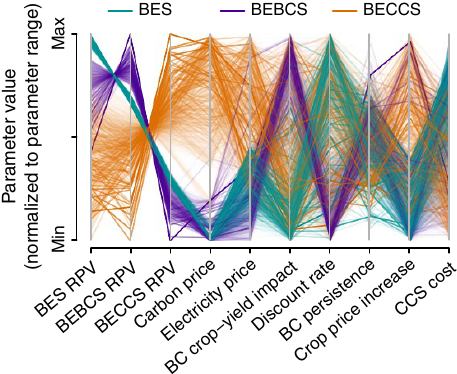
Figure 3 | Parallel coordinates plot of the relative net present values as a function of the most important parameters. Relative net present values (RPVs) of bioenergy systems (BES), bioenergy with carbon capture and storage (BECCS) and bioenergy-biochar systems (BEBCS), and the principal factors on which these RPVs depend, in the years 2020, 2050 and 2100, are shown here with each of the seven most important parameters (see Fig. 2) plotted on parallel axes, to allow depiction of a multidimensional parameter space in a two-dimensional image. Each line represents a single data point in the Monte Carlo simulation, connecting the values of each variable for that point. The number of Monte Carlo simulations plotted was limited to 4,500 (750 randomly sampled from each of the six scenario-year combinations) to prevent over-cluttering the plot and to ensure high visibility of the main trends. Parameter values are normalized linearly within their sample ranges so that the y axes of all parameters share a common scale that is linearly interpolated between the parameter minimum and maximum. Line transparency is graduated by RPV (darker, less transparent lines for higher RPV), also to increase visibility of the main trends. Lines are coloured by which technology is optimal under the specified conditions (cyan, BES, purple, BEBCS and orange,